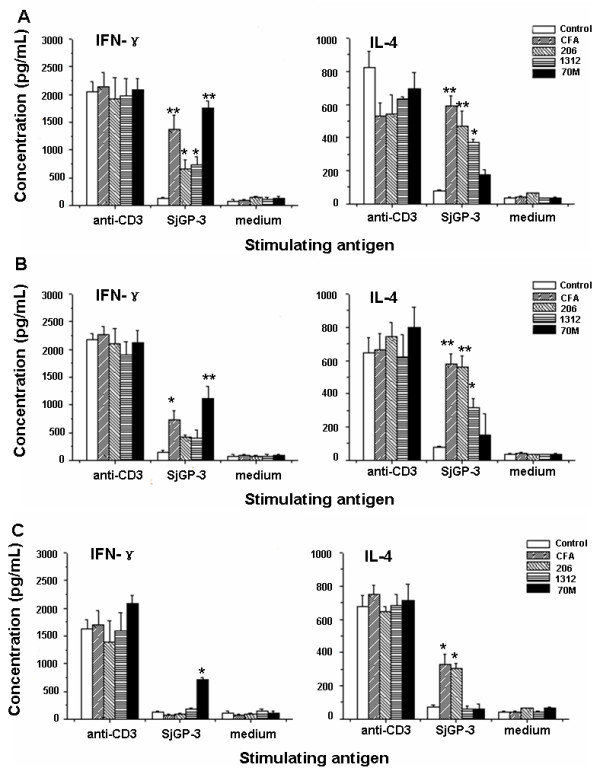
Analysis of cytokine production. Spleen cells were harvest from mice immunized with the SjGP-3 formulated by various adjuvants (three mice each group) on week 9 (before challenge), 12 (three weeks after cercarial challenge) and 15 (six weeks after cercarial challenge), and stimulated in vitro with anti-CD3, SjGP-3 protein or medium in duplicate wells respectively. The IL-4 and IFN-γ production in the culture supernatants of spleen cells was analyzed by ELISA in triplicate wells. Data correspond to the mean values ± standard deviation. (A) Week 9. (B) Week 12. (C) Week 15. * p < 0.05, ** p < 0.01 when compared with PBS control group.